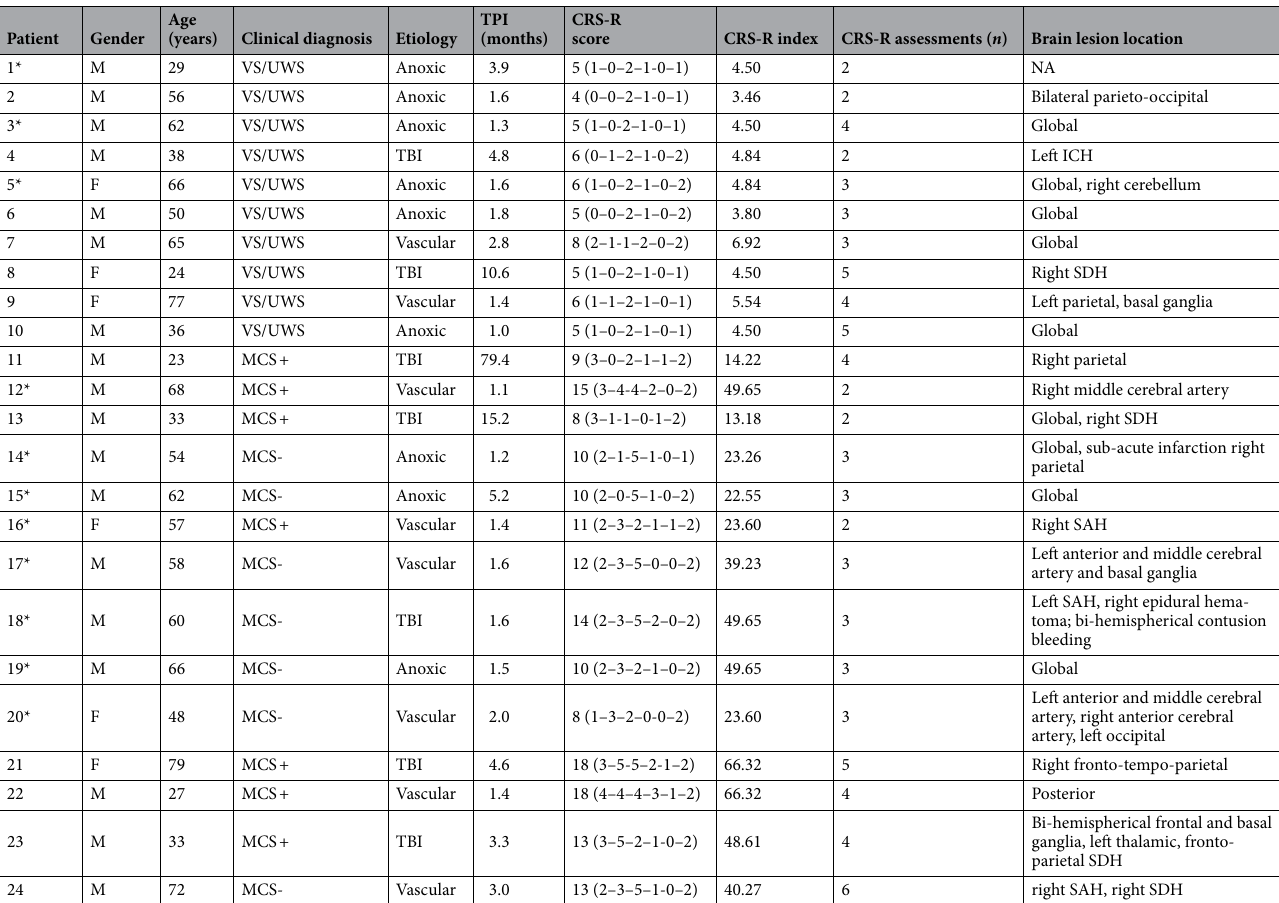
Table 1. Characteristics of the patients. Patients’ best CRS-R total score (and relative sub-scores: auditory- visual-motor-oromotor/verbal-communication-arousal) out of the repeated examination is reported. The asterisk * indicates the patients who completed the full oddball paradigm. Abbreviations: TPI = Time Post-Injury; CRS-R = Coma Recovery Scale-Revised; M = Male; F = Female; VS/UWS = Vegetative State/ Unresponsive Wakefulness Syndrome; MCS = Minimally Conscious State; TBI = Traumatic Brain Injury; NA = Not Available; ICH = Intra-Cerebral Hemorrhage; SDH = Sub-Dural Hemorrhage; SAH = Sub-Arachnoid